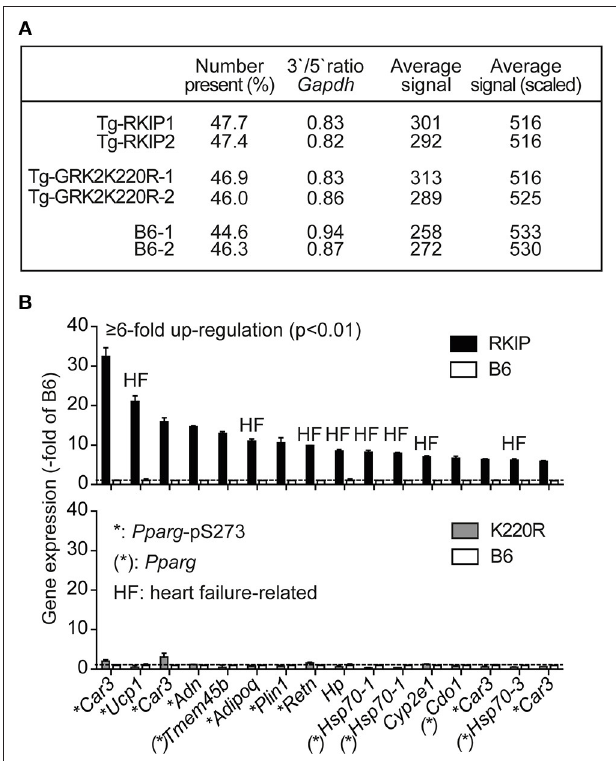
FIGURE 5 | Up-regulation of heart failure-related Pparg target genes in Tg-RKIP hearts. (A,B) Cardiac whole genome microarray gene expression profiling (A) identified highly up-regulated probe sets ( ≥ 6-fold up-regulation compared to B6 with p < 0.01) in Tg-RKIP hearts ( B , upper panel). None of these probe sets was significantly regulated in Tg-GRK2K220R hearts ( B , lower panel). Gene expression data are expressed as -fold of B6 ( ± s.d., n = 2 gene chips/group with total RNA isolated from n = 3 hearts/gene chip). Highly up-regulated genes ( ≥ 6-fold up-regulation in Tg-RKIP hearts compared to B6 hearts; p < 0.01; with call present and/or signal intensity ≥ 100) in Tg-RKIP hearts have documented relationship to heart failure (HF), are Pparg targets [(*): Pparg )], and/or are induced by Pparg serine-273 phosphorylation (*: Pparg